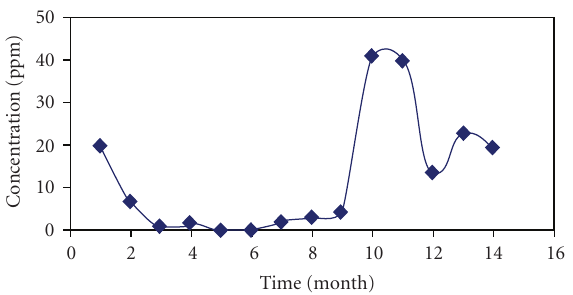
Figure 5: Cl ion concentration in the